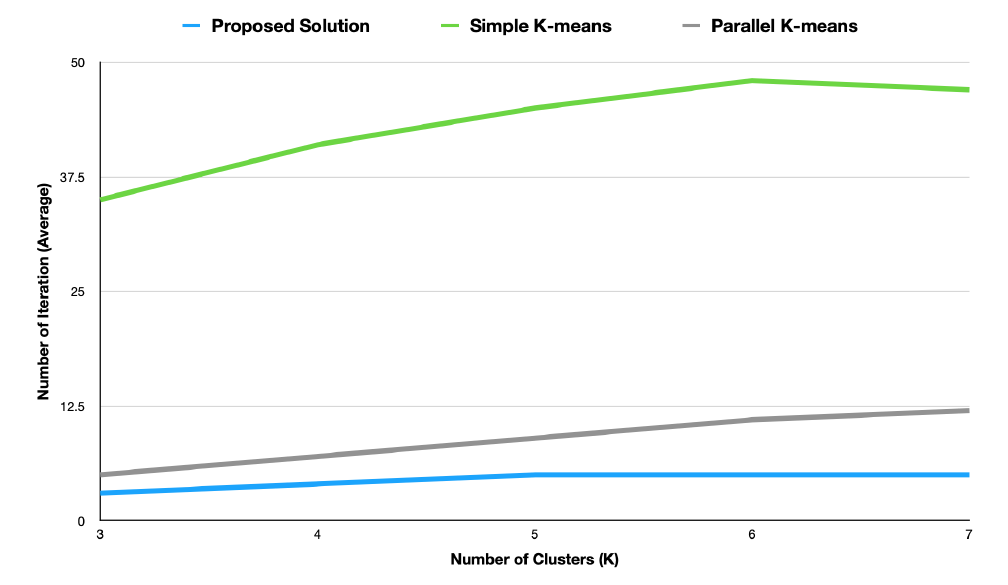
Figure 8. Number of iterations for the Google Play Store